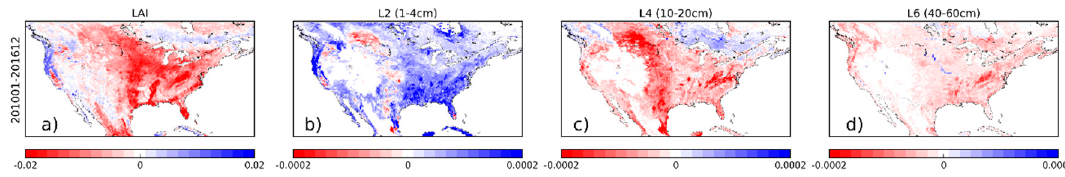
Figure 5. Analysis increments averaged over the 2010–2016 time period for ( a ) LAI in m 2 m − 2 , ( b ) second, ( c ) fourth, and ( d ) sixth layer of soil moisture in m 3 m − 3 .